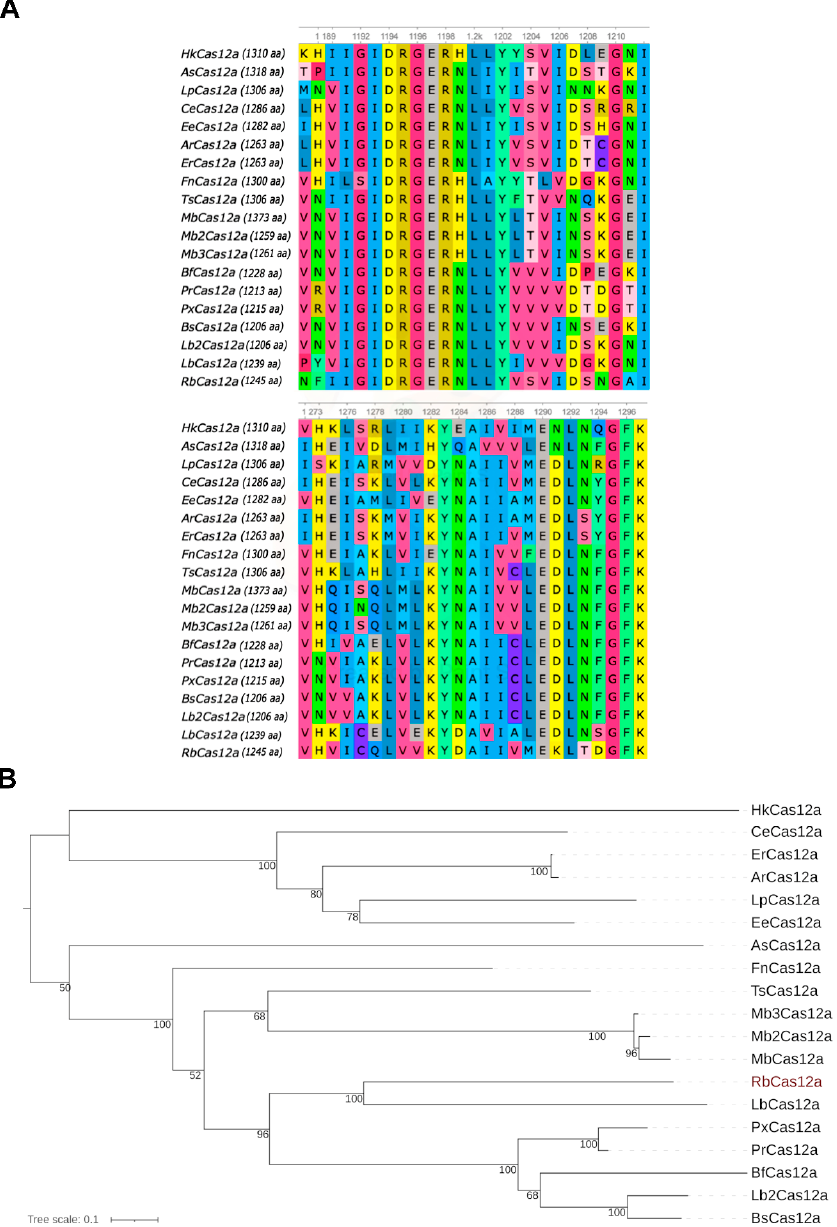
Figure 1. Relationship of RbCas12a to other Cas12a orthologs. ( A ) Multiple sequence alignments of RbCpf1 with common orthologs of 18 Cas12a proteins that function in human cells. Catalytic Asp1194 and Glu1290 residues (numeration shown here for total alignment) are conserved (HkCas12a, Helcococcus kunzii ATCC 51366; CeCas12a, Coprococcus eutactus sp.; ErCas12a, Eubacterium rectale sp.; ArCas12a, Agathobacter rectalis strain 2789STDY5834884; LpCas12a, Lachnospira pectinoschiza strain 2789STDY5834886; EeCas12a, Lachnospira eligens ATCC 27750; AsCas12a, Acidaminococcus sp. BV36L; FnCas12a, Francisella novicida U112; TsCas12a, Thiomicrospira sp. XS5; Mb3Cas12a, Moraxella bovoculi sp.; Mb2Cas12a, Moraxella bovoculi AAX08_00205; MbCas12a, Moraxella bovoculi 237; RbCas12a, Ruminococcus bromii sp.; LbCas12a, Lachnospiraceae bacterium ND2006; PxCas12a, Pseudobutyrivibrio xylanivorans strain DSM 10317; PrCas12a, Pseudobutyrivibrio ruminis CF1b; BfCas12a, Butyrivibrio fibrisolvens MD2001; Lb2Cas12a, Lachnospiraceae bacterium MA2020; BsCas12a, Butyrivibrio sp. NC3005). ( B ) Neighbor-joining tree without distance